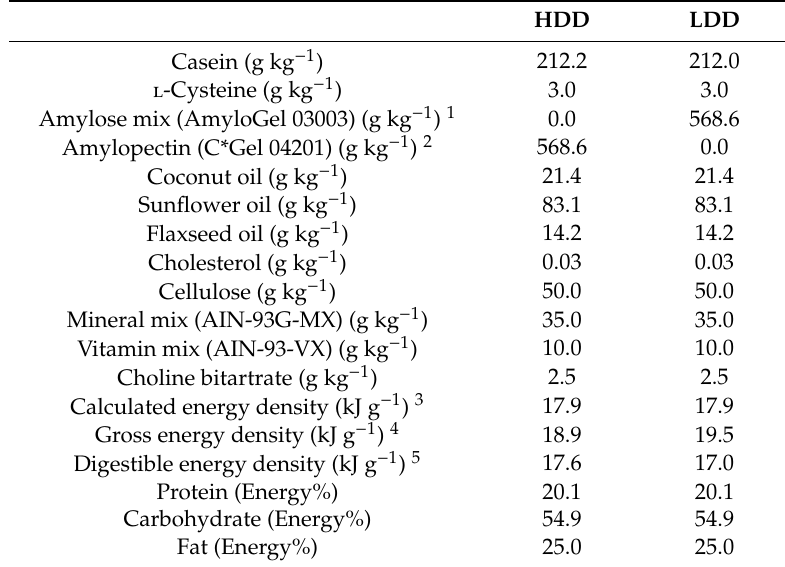
Table 1. Composition of the experimental